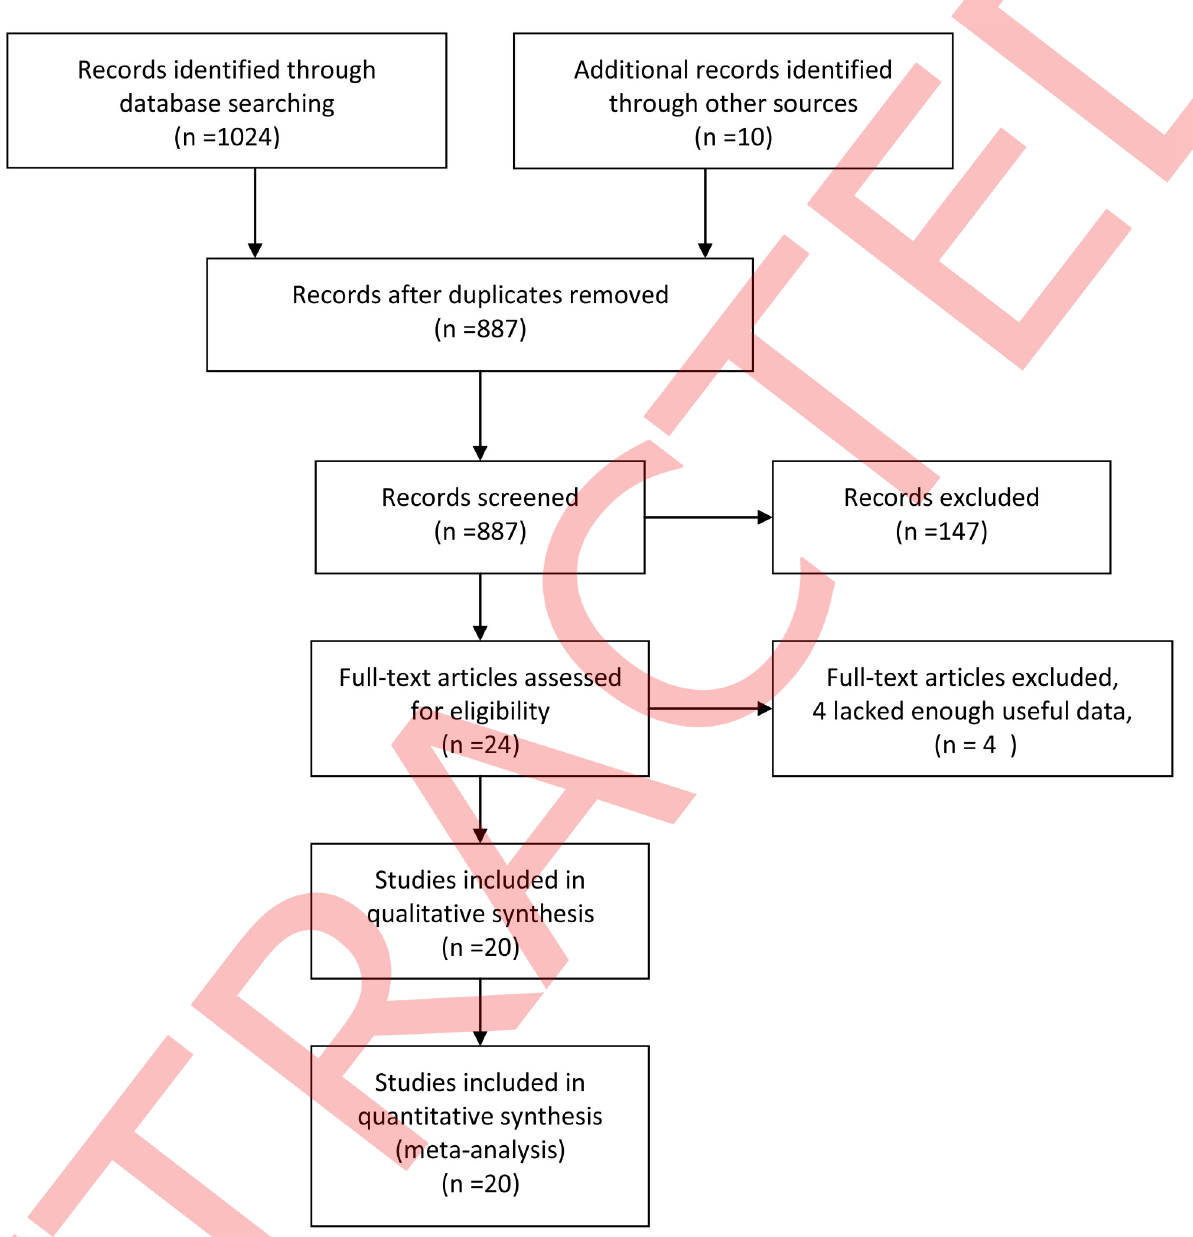
Fig 1. Flow diagram of study